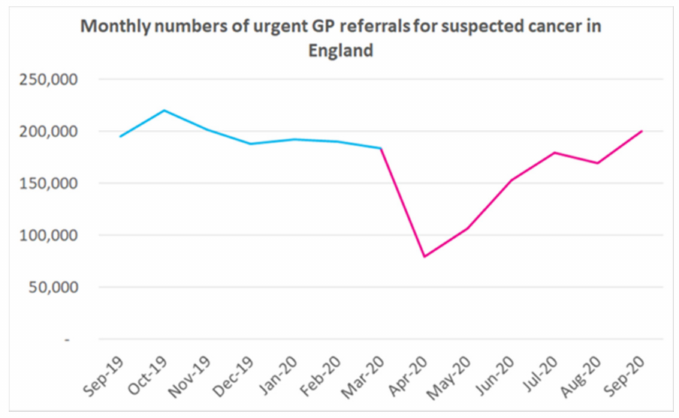
Figure 1. Courtesy of CRUK—https://www.cancerresearchuk.org/health-professional/diagnosis/